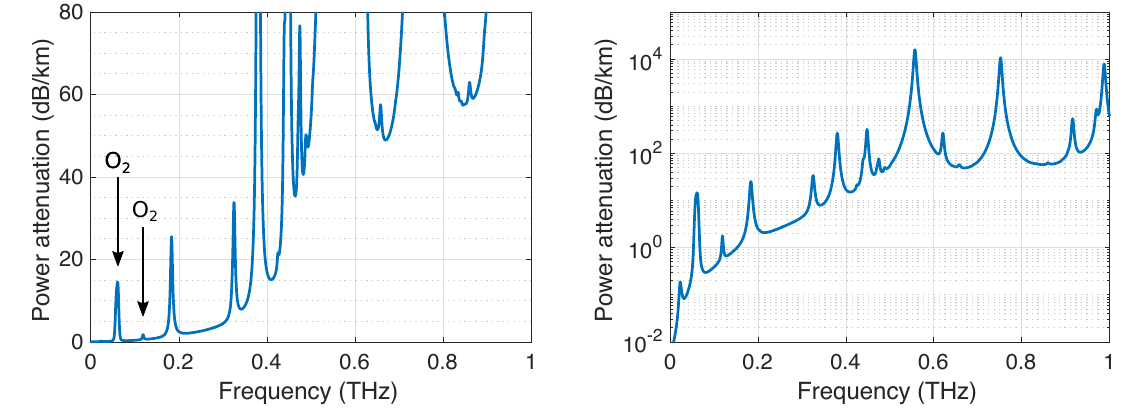
Figure 1. Terahertz wave atmospheric power attenuation for temperature T = 20 ◦ C and water vapor density ρ WV = 7 g/m 3 at sea level. Left and right plots shows linear and logarithmic scale, respectively. Left plot indicates two predominant molecular oxygen (O 2 ) absorption lines at 60 GHz and 120